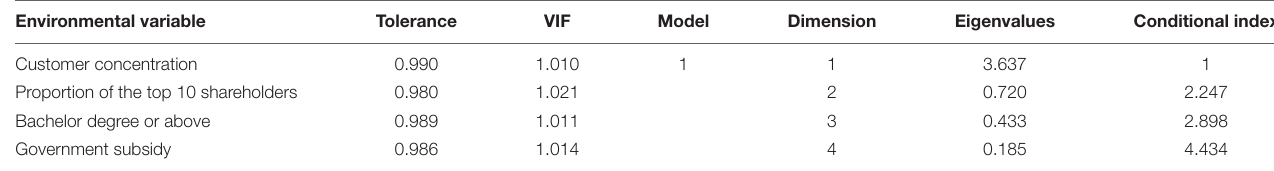
TABLE 4 | Collinear